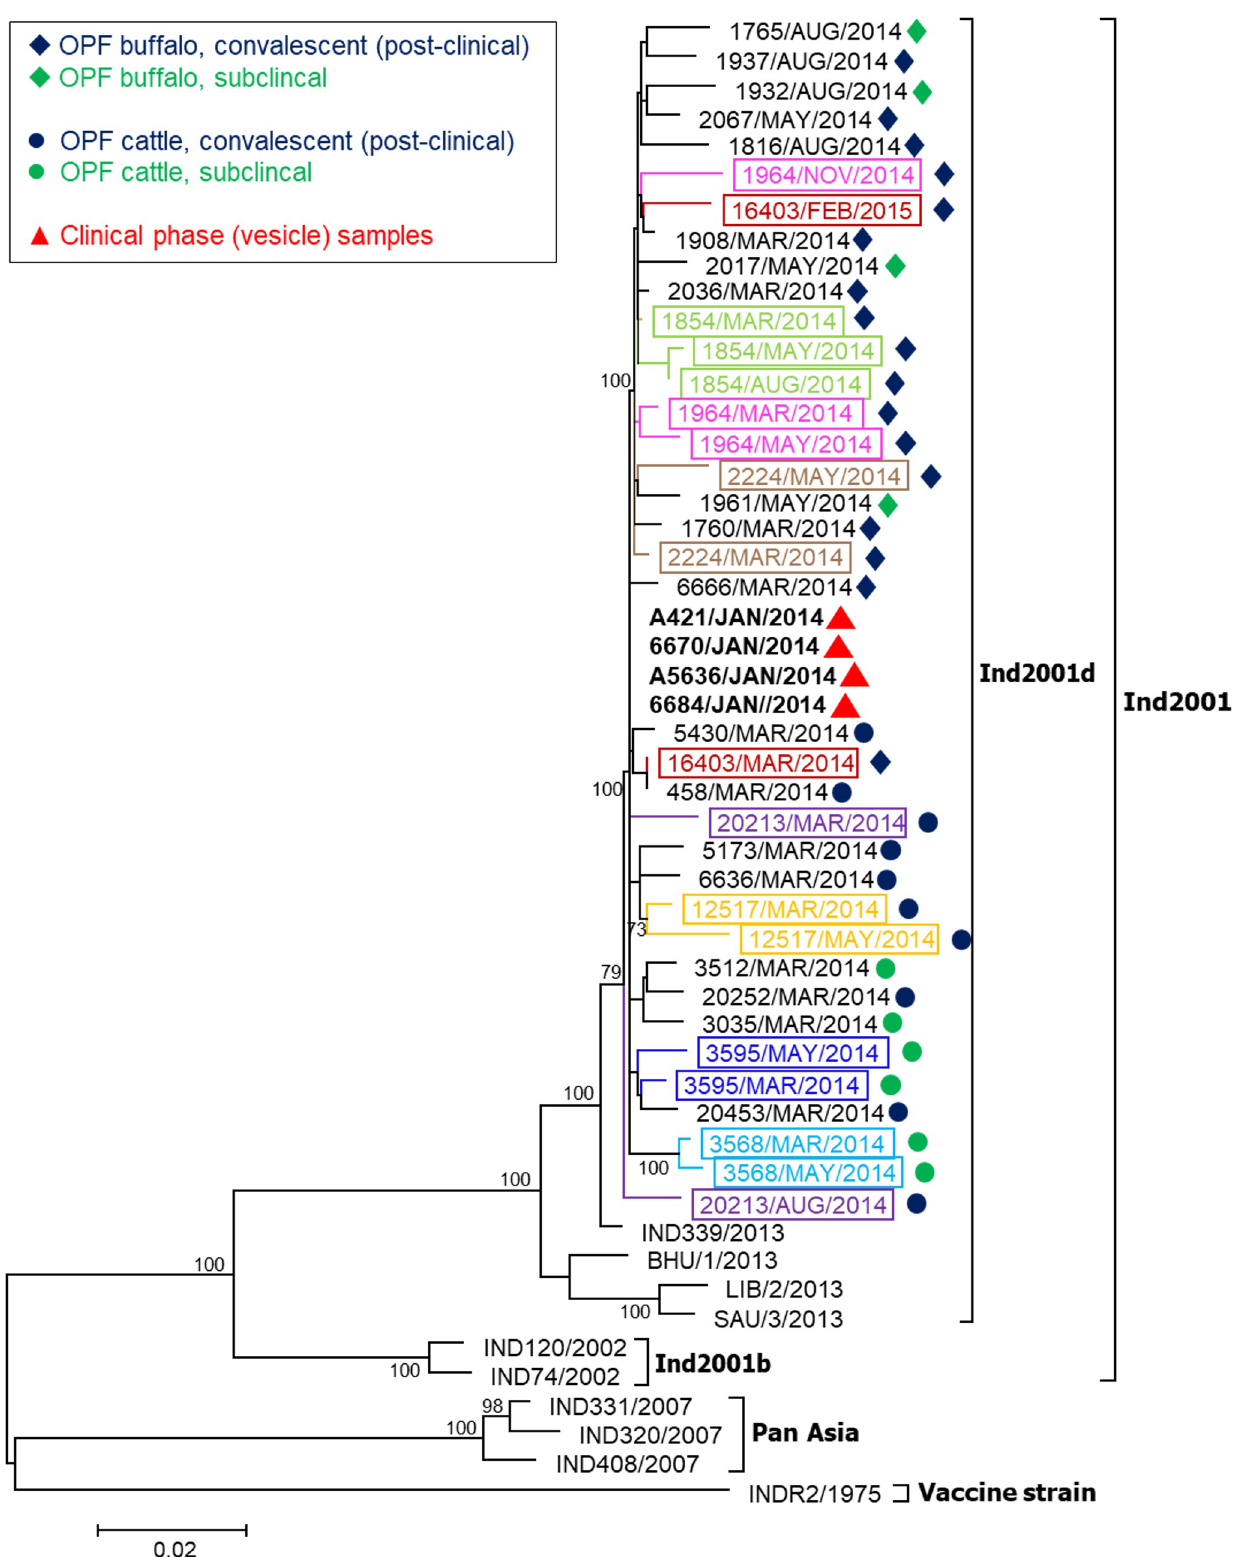
Fig 3. Phylogenetic tree estimated using the maximum likelihood method for theP1-capsid coding region of outbreak (acute) and carrier FMDV isolates. Bootstrap values ( > 70%, out of 10,000 replicates) are shown near the nodes. Coloured outlines and text denote samples from the same animal. https://doi.org/10.1371/journal.pone.0214832.g003 PLOS ONE | https://doi.org/10.1371/journal.pone.0214832 June 21,